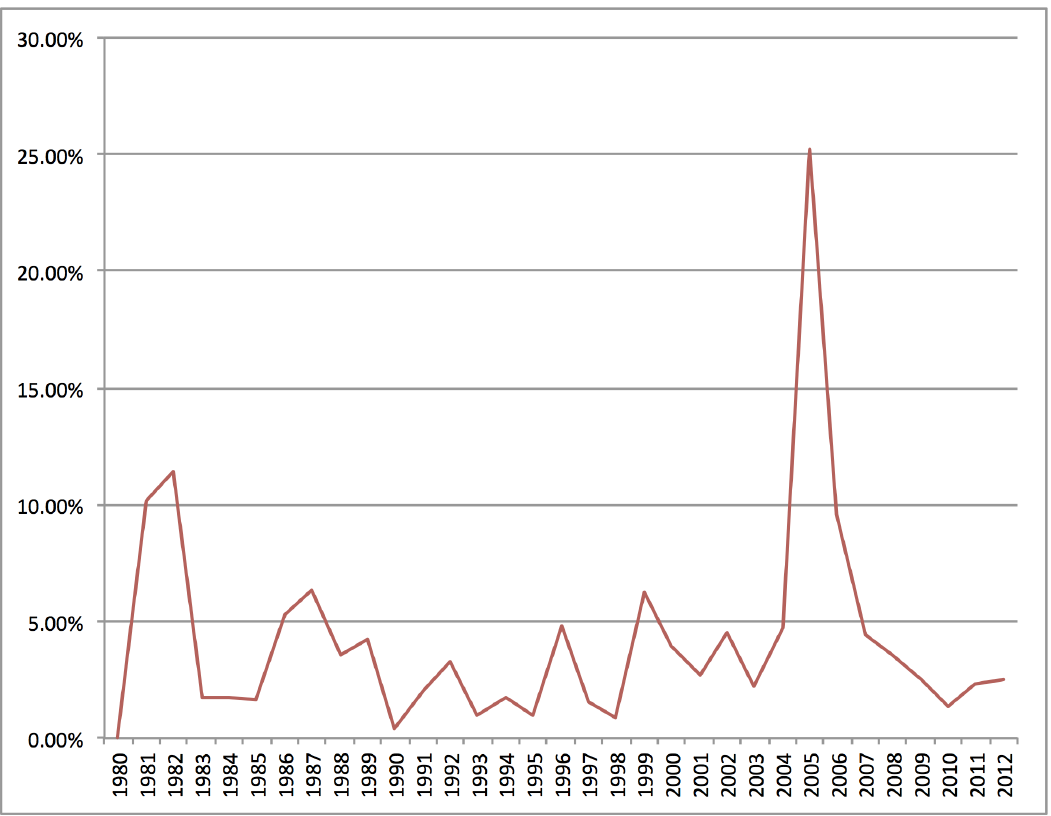
Figure 6. Prominence of evolution in demarcation corpus over time. Percentage of documents in each year with at least 15% evolution content.